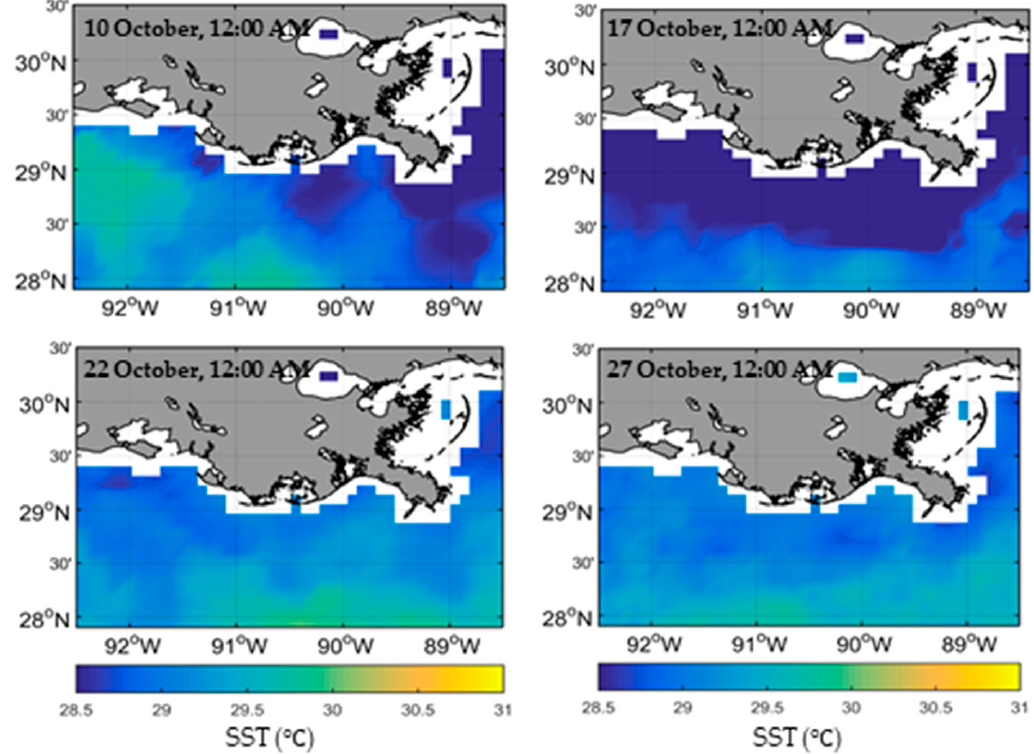
Figure 9. Satellite OI SST maps over the Louisiana shelf at times corresponding to the different cold front events in October 2009.